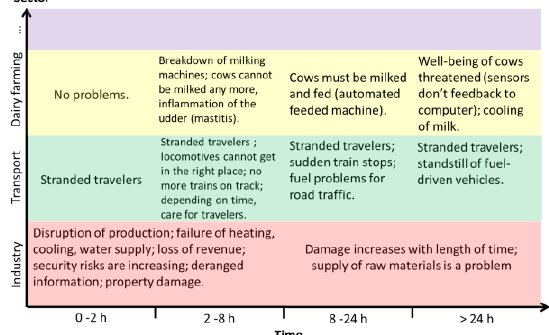
Figure 9. Temporal effect-chain of social disruption after a